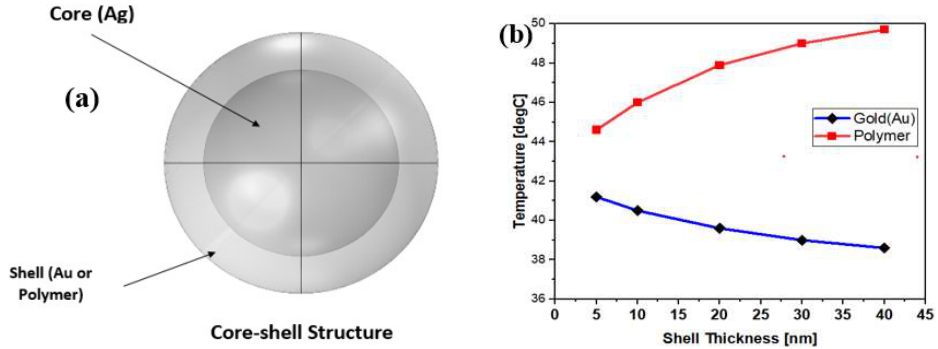
Figure 8. ( a ) The core–shell structure, ( b ) maximum temperature obtained by coating of gold and PEG polymer shell of thickness 5, 10, 20, 30 and 40 PEG polymer shell of thickness 5, 10, 20, 30 and 40 nm.